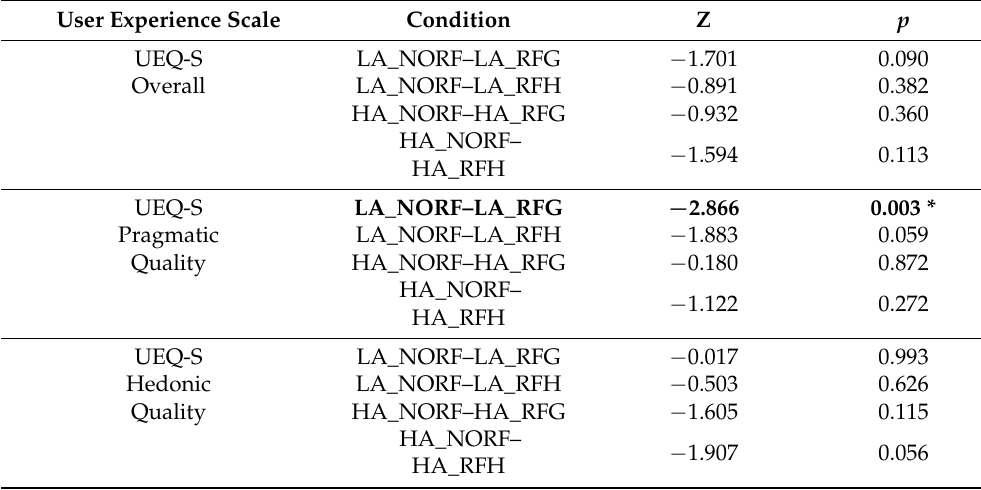
Table 6. Wilcoxon signed-rank test for user experience scores assessed by the UEQ-S Questionnaire between the no rest-frame and rest-frames conditions.